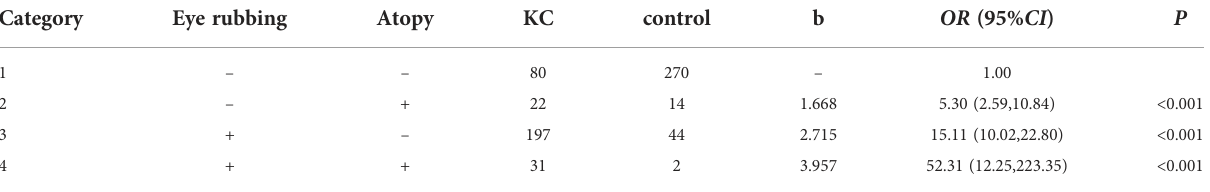
TABLE 3 Joint effect of eye rubbing and atopy on KC.